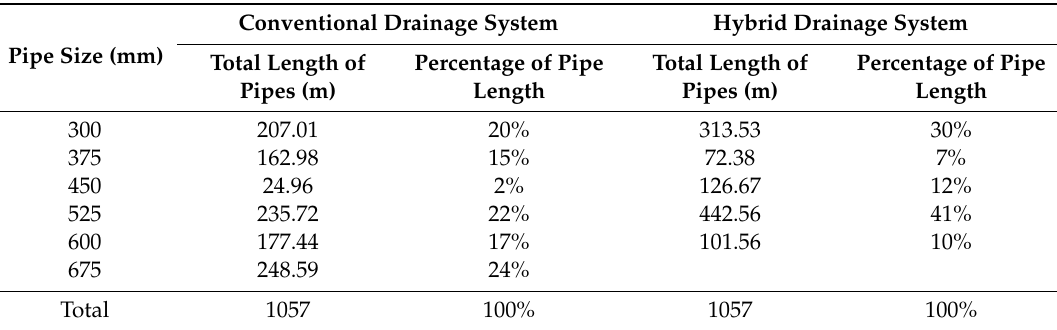
Table 4. Comparison of pipe size and length between two drainage